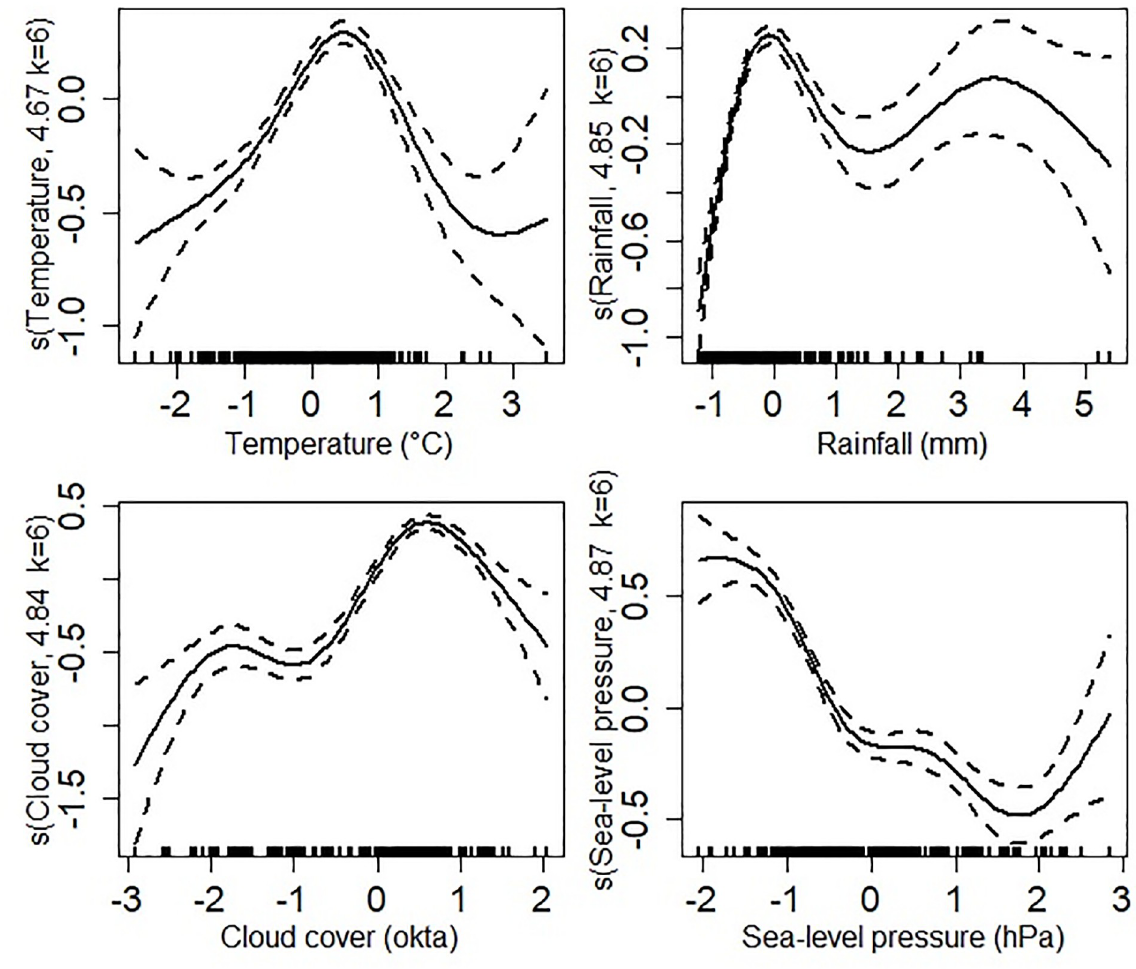
Fig 5. Response curves of the dengue occurrence ratio as a function of the four most relevant variables (horizontal axis). Dashed lines are the 95% confidence interval for smoothed terms. The values on the vertical axis are the optimal smoothing parameters (k) estimated with the mgcv package of